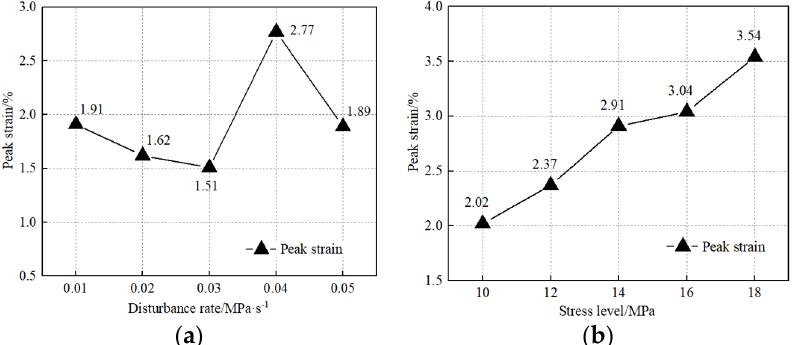
Figure 9. Relationship of static stress control variables and peak strain: ( a ) disturbance rate; ( b ) stress level.